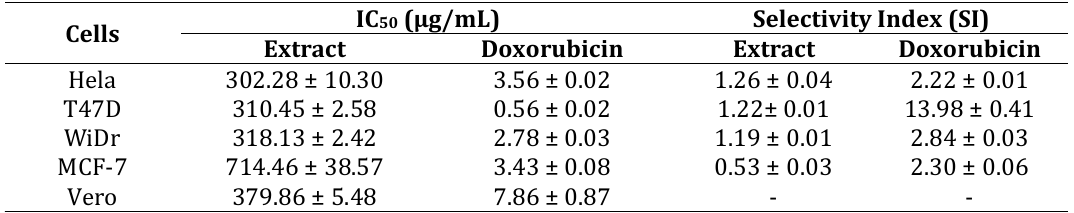
Table IV. IC 50 values of the extract of broth medium fermentation of E. linearis and doxorubicin control against several cell